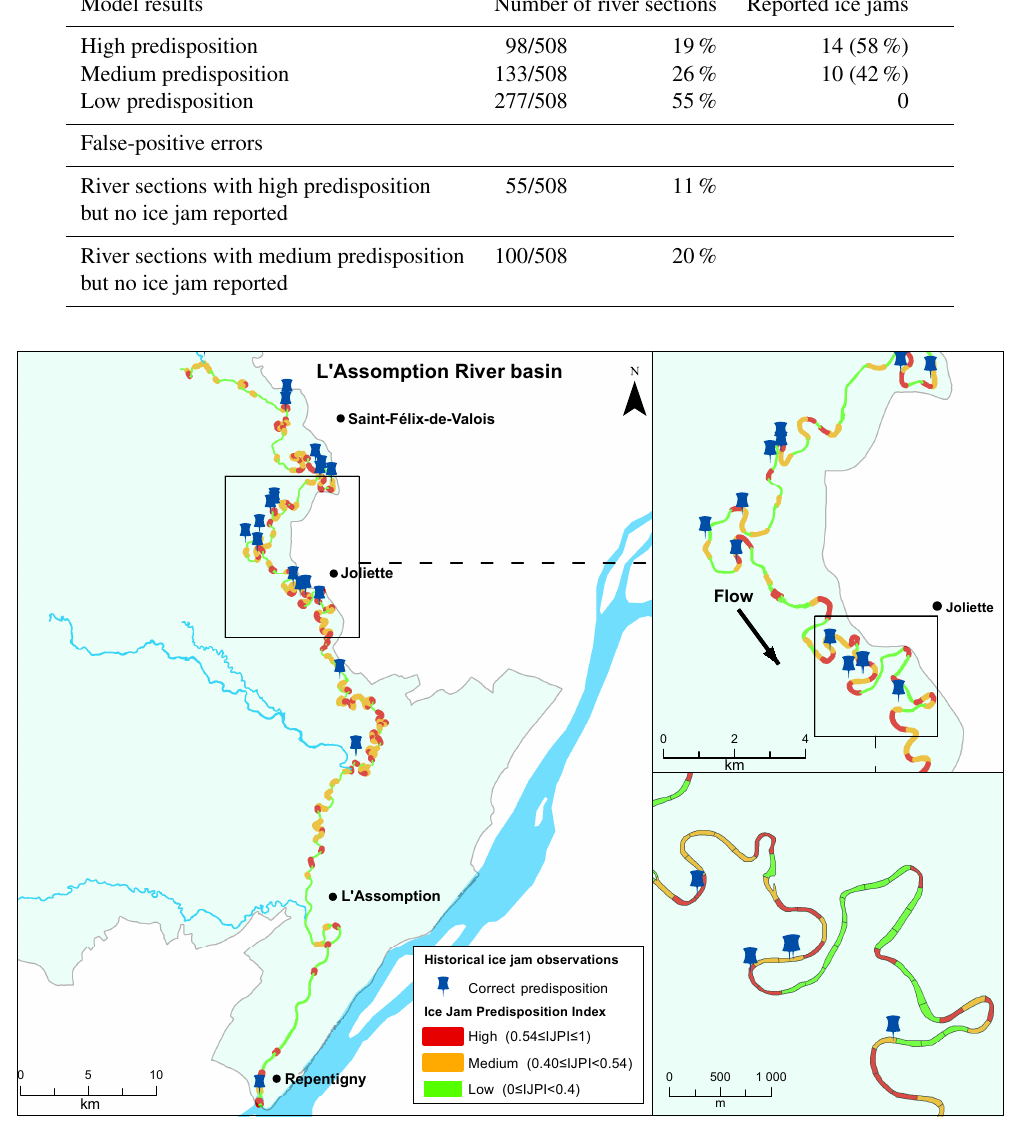
Figure 9. Map of the model results on L’Assomption River, over 250m sections. Thumbnails are the locations of reported ice jams. Blue is used when the ice jam falls on a section with a moderate to high predisposition (correct assessment). Magenta is used when the ice jam falls on a section with a low predisposition (false-negative